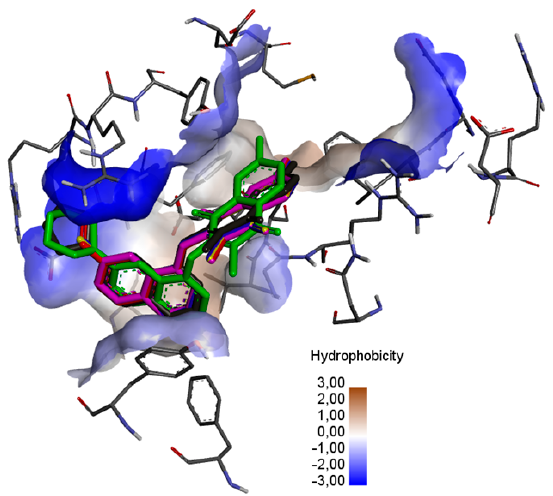
Figure 7. The superposition of the docked ligand: 13 (purple), 14 (blue), 15 (red), 16 (yellow), 17 (green), and 18 (grey) in the binding site of the BCL-2 protein. Comparing the arrangement of 2-methylo-5,8-quinolinedione ( 13 – 18 ) (Figure 8) with Venetoclax (Figure S2) shows that tested ligand interacts with similar amino acid residues in the active center of the BCL-2 protein. The hybrids 13 – 18 and reference substance interact with phenylalanine (PHE63), tyrosine (TYR67) and glycine (GLY104).